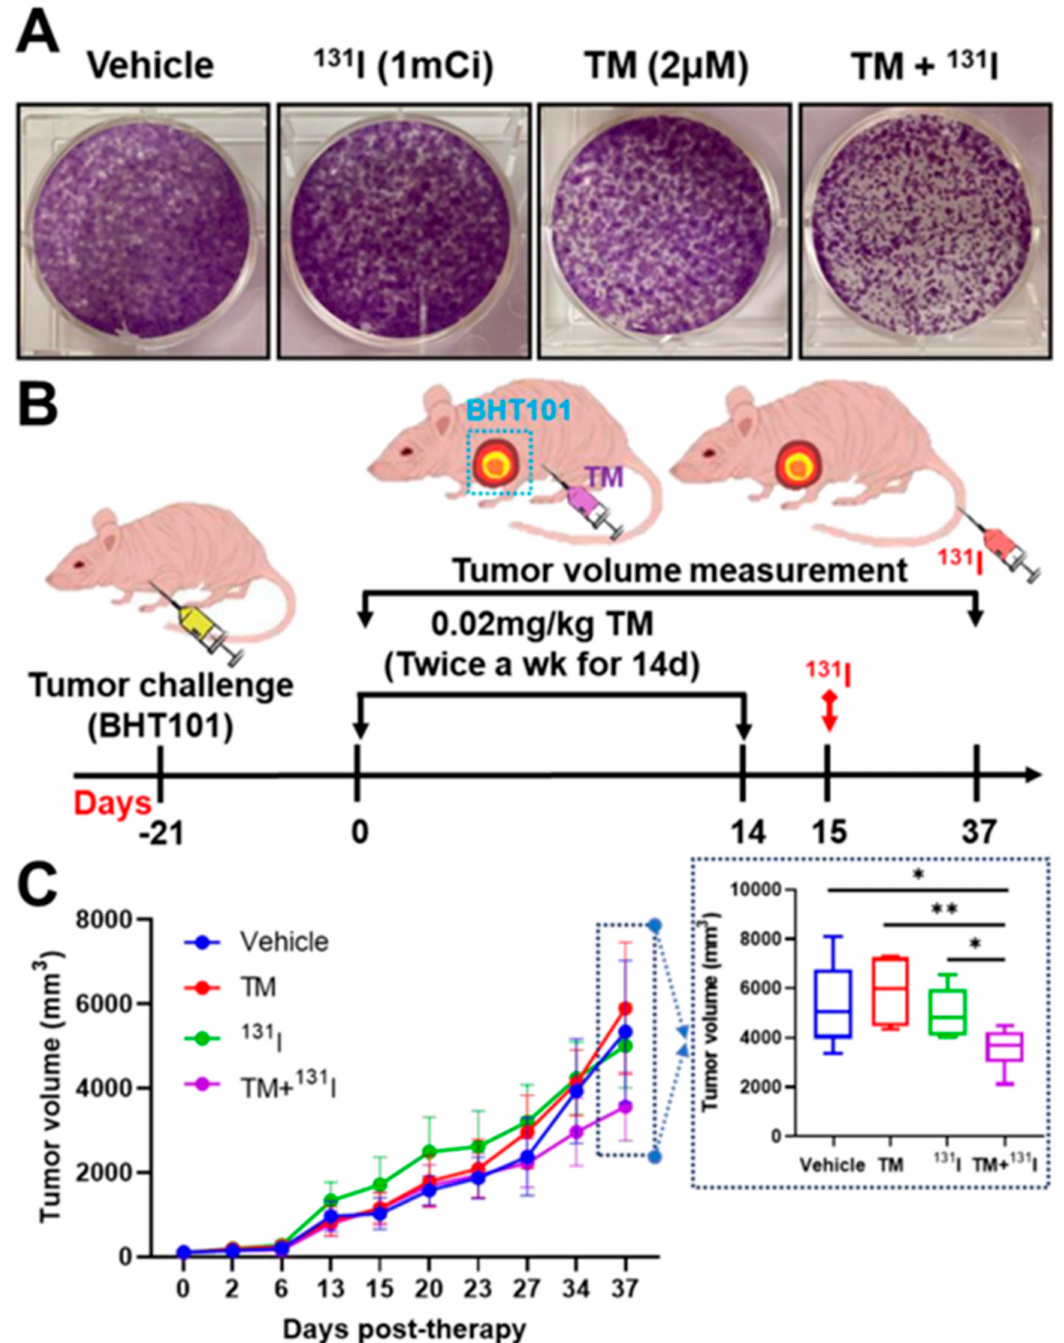
Figure 5. Evaluation of therapeutic response to 131 I therapy with TM treatment . ( A ) Colony formation assay. BHT101 cells treated with 2 µ M TM and 1 mCi 131 I were seeded onto 6-well plates, followed by further incubation for 14 days. After fixation, the cells were stained with crystal violet solution. ( B ) Brief scheme for in vivo therapy. When tumor mass was detectable by palpation and inspection, BHT101 tumor-bearing mice received 0.02 mg/kg TM via intraperitoneal injection twice a week for 2 weeks, followed by 1 mCi 131 I treatment intravenously. Tumor volume was measured with a caliper at indicated times. ( C ) Tumor volume measurement. * p < 0.05, ** p < 0.005, compared with vehicle, TM, and 131 I, respectively. Data are the mean ± SD of 7 or 8